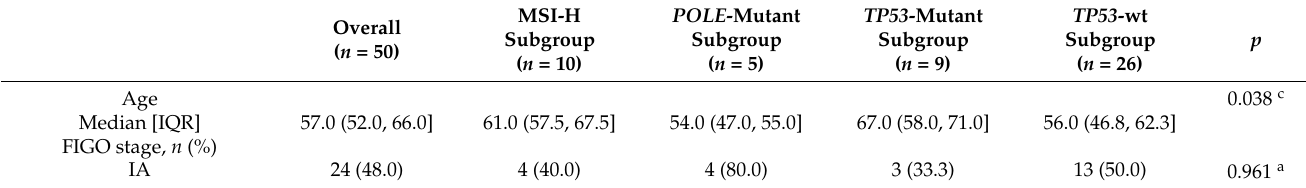
Table 1. Characteristics of